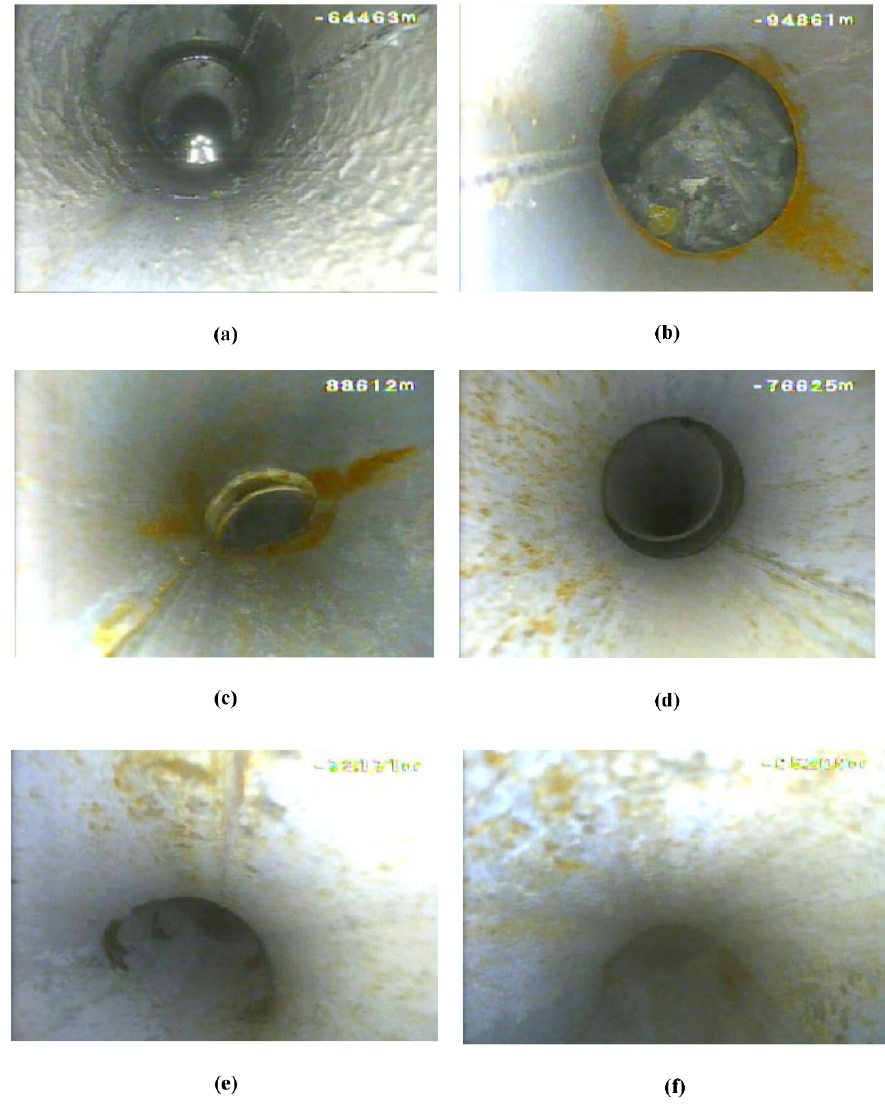
Figure 5. Observation results of borehole No. 1. ( a ) Water accumulation location at −64.46 m; Error hole position at ( b ) −94.86 m, ( c ) −88.61 m, ( d ) −78.82 m, ( e ) −73.17 m, and ( f ) −35.20 m. hole position at ( b ) − 94.86 m, ( c ) − 88.61 m, ( d ) − 78.82 m, ( e ) − 73.17 m, and ( f ) − 35.20